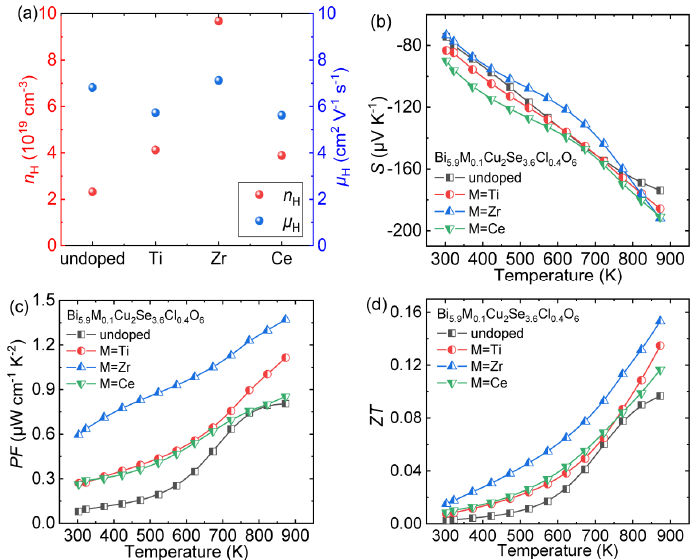
Figure 11. Thermoelectric transport properties of Bi 6 Cu 2 Se 3 . 6 Cl 0 . 4 O 6 and Bi 5 . 9 M 0 . 1 Cu 2 Se 3 . 6 Cl 0 . 4 O 6 (M = Ti, Zr, Ce): ( a ) carrier concentration ( n H ) and mobility ( μ H ) at room temperature, ( b ) Seebeck coefficient, ( c ) power factor and ( d ) ZT . Data shown in ( b – d ) were adopted from Reference [30]. Copyright 2021, Acta Materialia